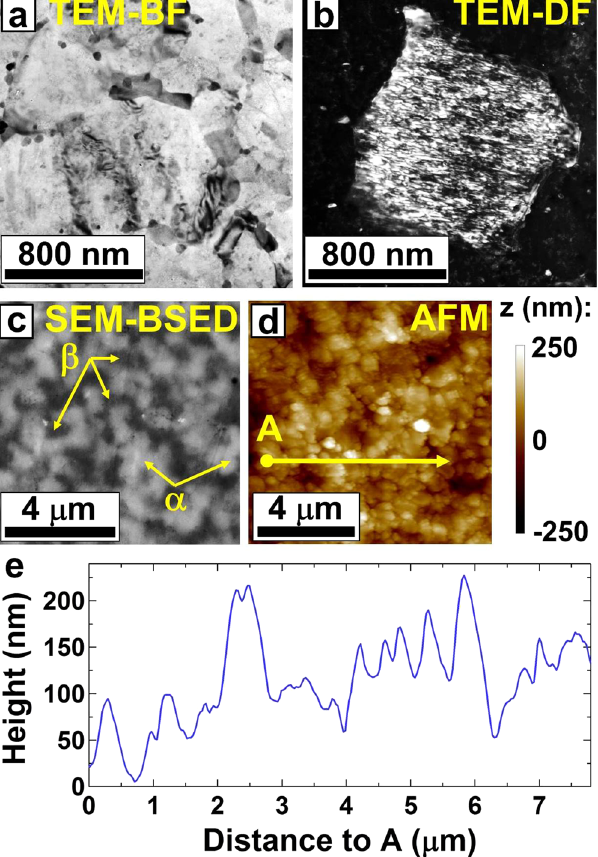
Figure 4. Absence of elongated grains, occurrence of grain coarsening, homogenous distribution of α and β phases and increase in the surface roughness after tensile test indicates the occurrence of grain boundary sliding. Microstructure and surface conditions of the sample processed by N = 200 cycles of SPD after tensile test to failure. ( a ) TEM-BF and TEM-DF images showing the morphology of the grains. ( c ) SEM-BSED image showing the distribution of α and β phases. ( d ) AFM image showing the surface roughness. ( e ) Plot of surface morphology along the direction indicated by an arrow in ( d